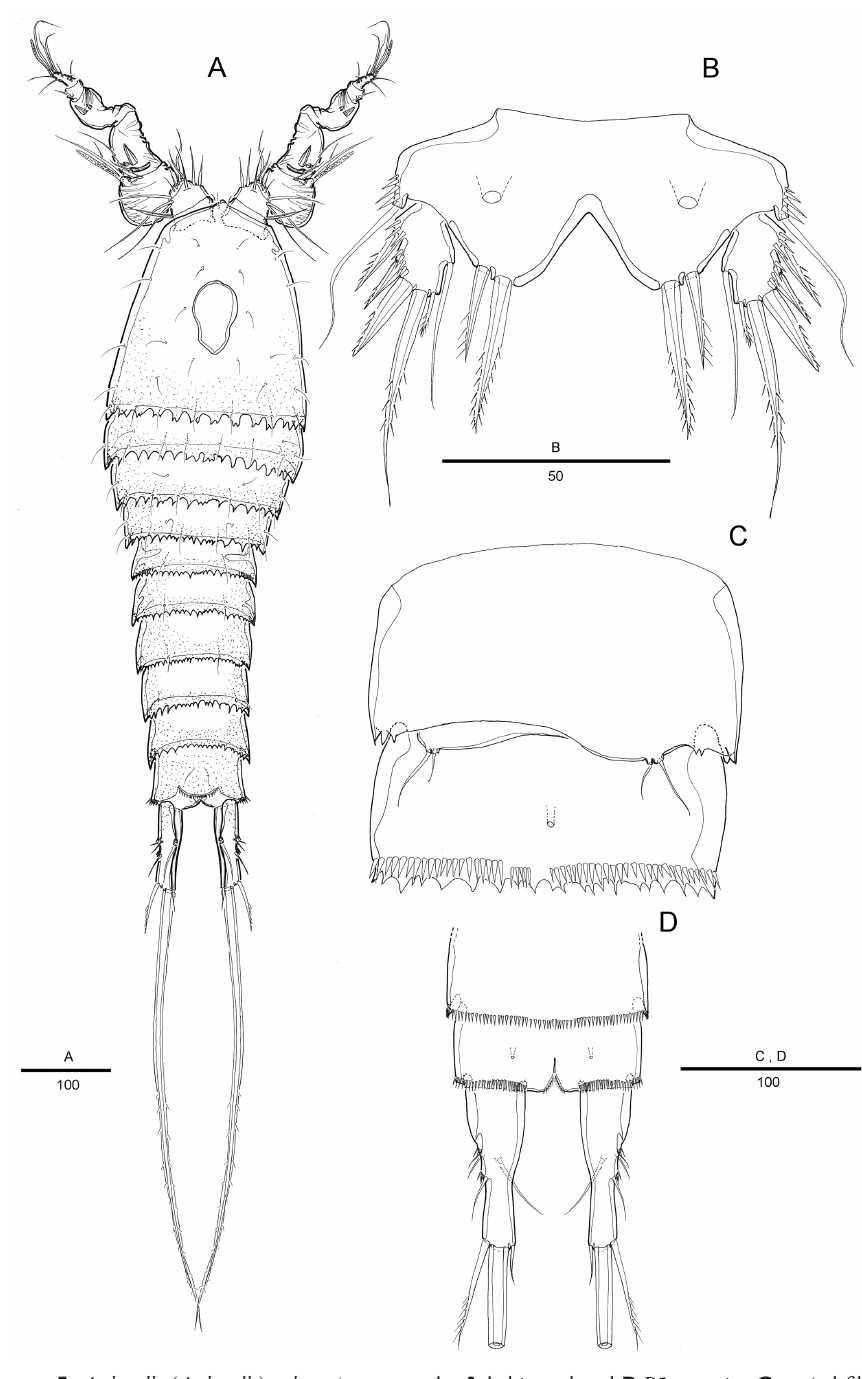
Figure 5. Attheyella ( Attheyella ) tahoensis sp. n. male: A habitus, dorsal B P5, anterior C genital filed, ventral D anal somite and caudal rami,